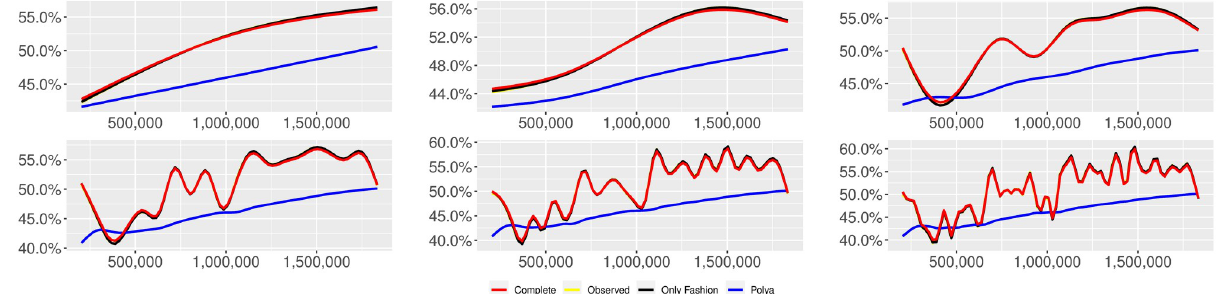
Fig 5. “Covid” ( T = 0.35, entire, D = 3 0 , S = 1000 slots of equal size): Sentiment curves. In each panel, the yellow line is the cubic spline smoothing of the time series of the observed tweets ξ , together with the default confidence interval (gray), the red line represents the cubic spline smoothing of the n +1 time series of the estimated predictive means ^ c (defined in Subsec. 3.2), obtained with the complete RP model, the black and the blue lines provide n similar approximations obtained with the other models: black = Only fashion RP model and blue = Standard Po´lya model. In each panel, the smoothing is obtained with a given number of nodes: k = 3 (top left panel), 5 (top middle panel), 10 (top right panel), 20 (bottom left panel), 30 (bottom middle panel), 50 (bottom right panel).